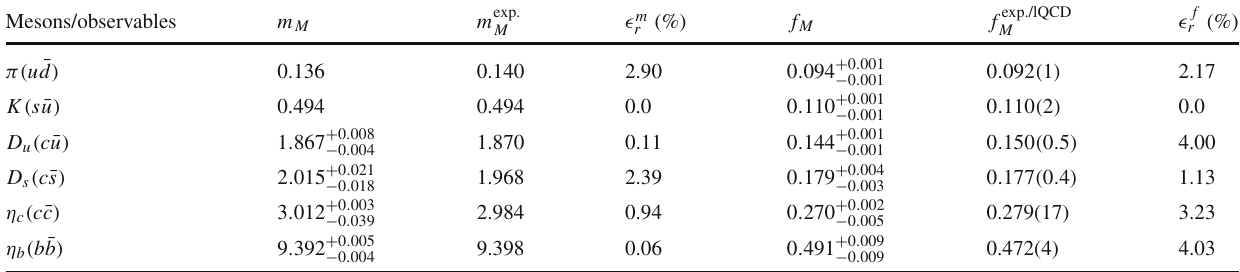
Table 3 Masses and decay constants (in GeV) of pseudoscalar mesons. Experimental masses and leptonic decay constants are taken from the Particle Data Group [90] except for the D and D s decay constants